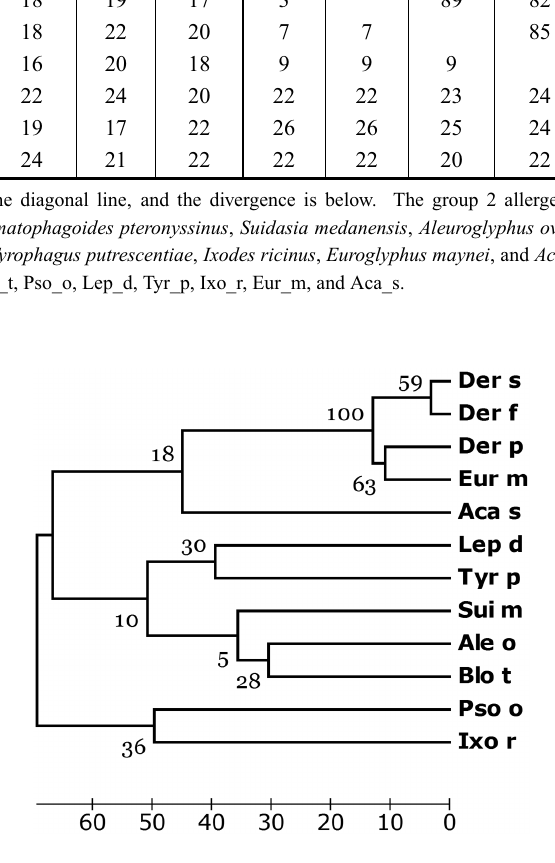
mites and ticks with maximum parsimony methods in Mega 4.0. The group 2 allergens of Dermatophagoides farinae , Dermatophagoides siboney , Dermatophagoides pteronyssinus , Suidasia medanensis , Aleuroglyphus ovatus , Blomia tropicalis , Psoroptes ovis , Lepidoglyphus destructor , Tyrophagus putrescentiae , Ixodes ricinus , Euroglyphus maynei and Acarus siro are abbreviated as Der_f, Der_s, Der_p, Sui_m, Ale_o,